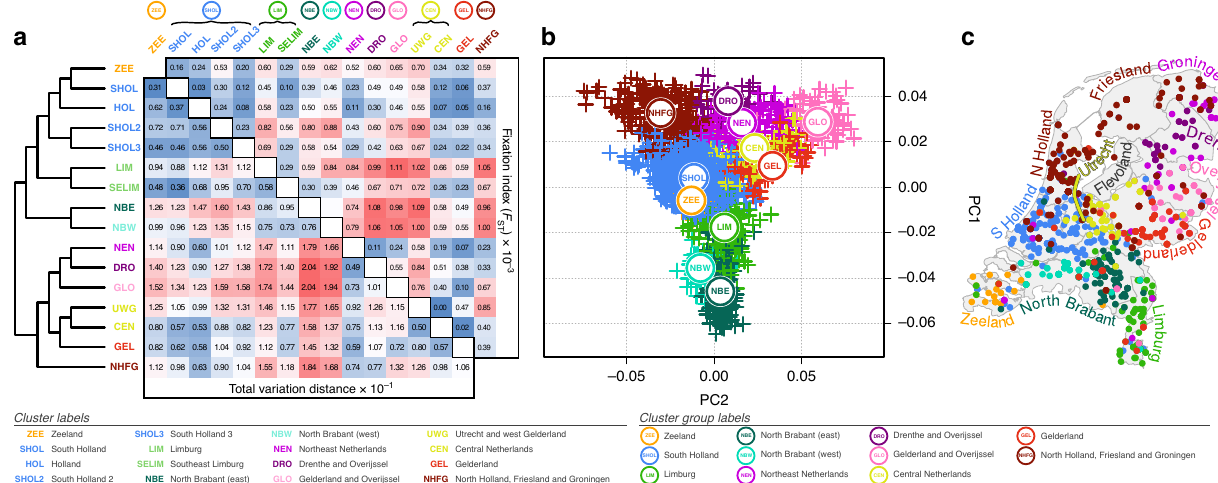
Fig. 1 The genetic structure of the people of the Netherlands. a fi neSTRUCTURE dendrogram of ChromoPainter coancestry matrix showing clustering of 1626 Dutch individuals based on haplotypic similarity. Associated total variation distance (TVD) and fi xation index statistics between clusters are shown in the matrix. Permutation testing of TVD yields p < 0.001 for all cluster pairs, indicating that clustering is non-random. Cluster labels derive from Dutch provinces and are arranged into cluster groups for genetically and geographically similar clusters (circled labels). b The fi rst two principal components (PCs) of ChromoPainter coancestry matrix for all individuals analysed. Points represent individuals and are coloured and labelled by cluster group. c Geographical distribution of 1422 sampled individuals, coloured by cluster groups de fi ned in a . Labels represent provinces of the Netherlands. Map boundary data from the Database of Global Administrative Areas (GADM; https://gadm.org).